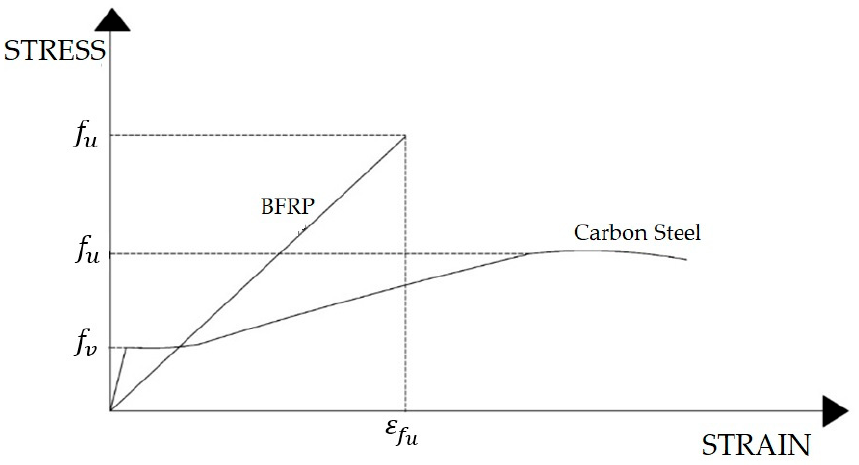
Figure 1. Typical stress–strain relationship of carbon steel and basalt fiber-reinforced polymer (BFRP) bars.